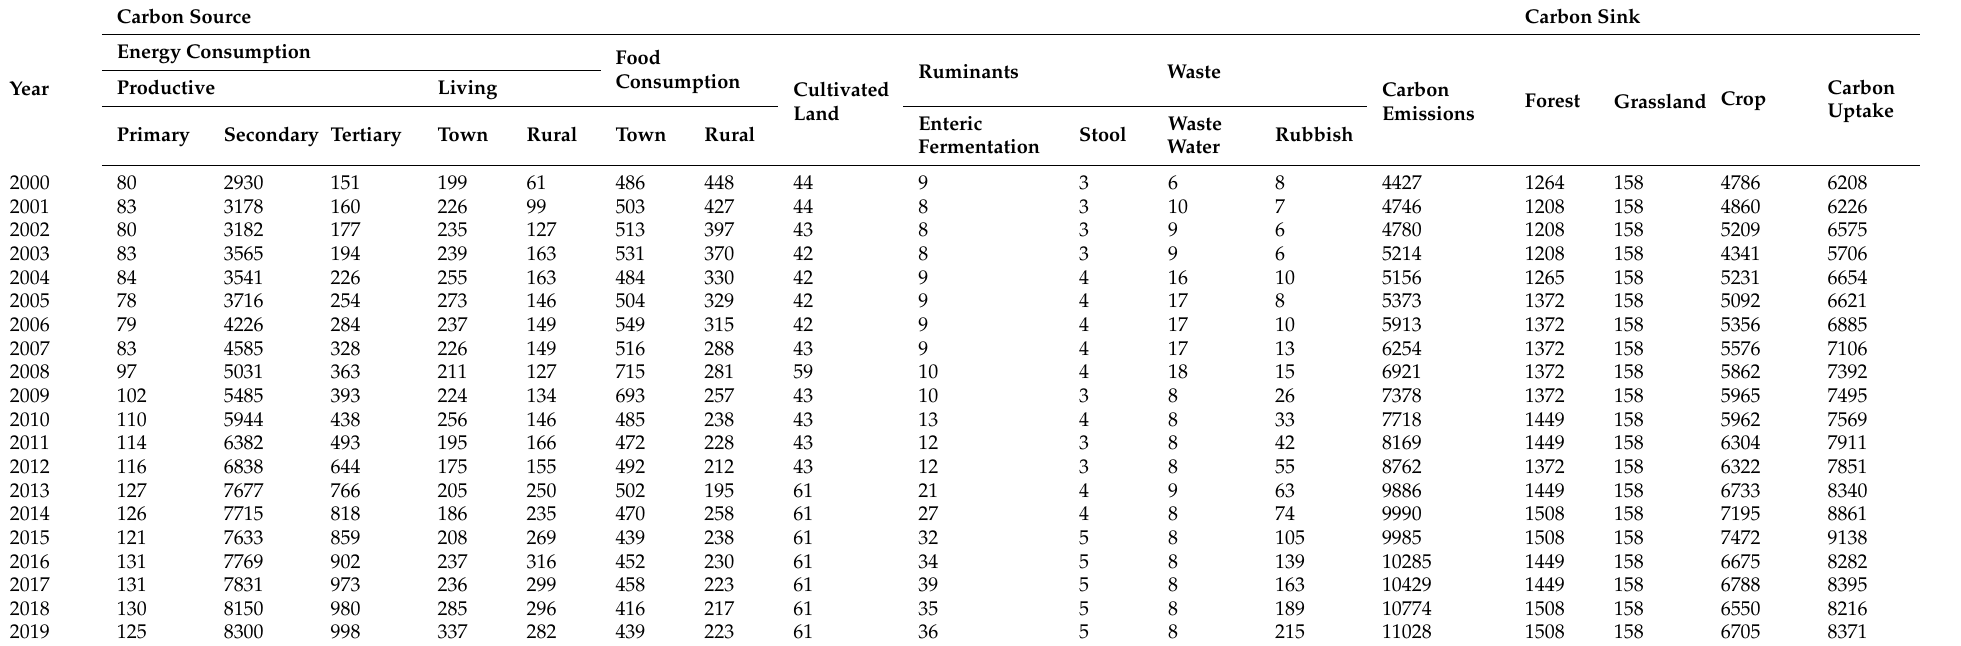
Table 5. The carbon emission inventory of Anhui Province (10,000